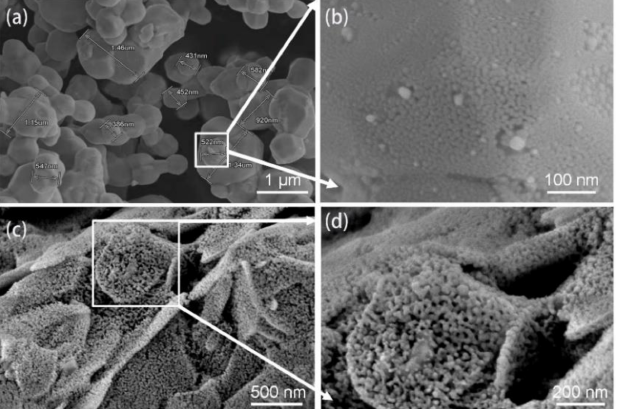
Figure 2. ( a ) SEM image of Ag 2 O powder, ( b ) high-magnification image of ( a ), ( c ) SEM image of Ag 2 O powder after the treatment in Pt-catalyzed formic acid vapor, and ( d ) high-magnification image of ( c